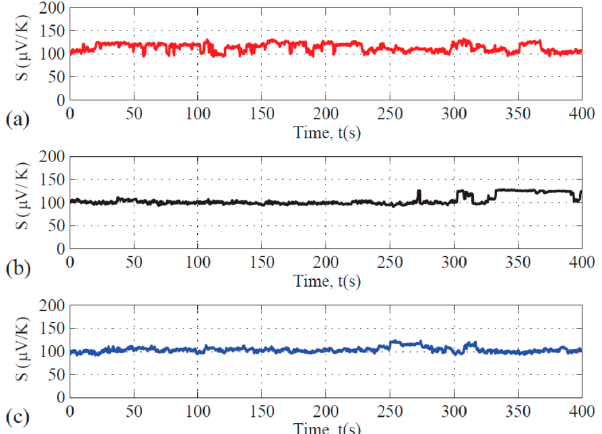
Figure 5. Seebeck coefficient measurement results of the thick coating obtained from various hot-end to cold-end temperature difference conditions: ( a ) with Δ T = 15 °C; ( b ) with Δ T = 10 °C; ( c ) with Δ T = 8 °C.